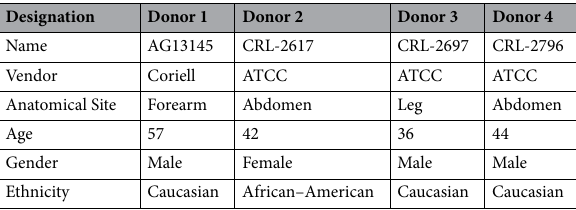
Table 1. HDF donor